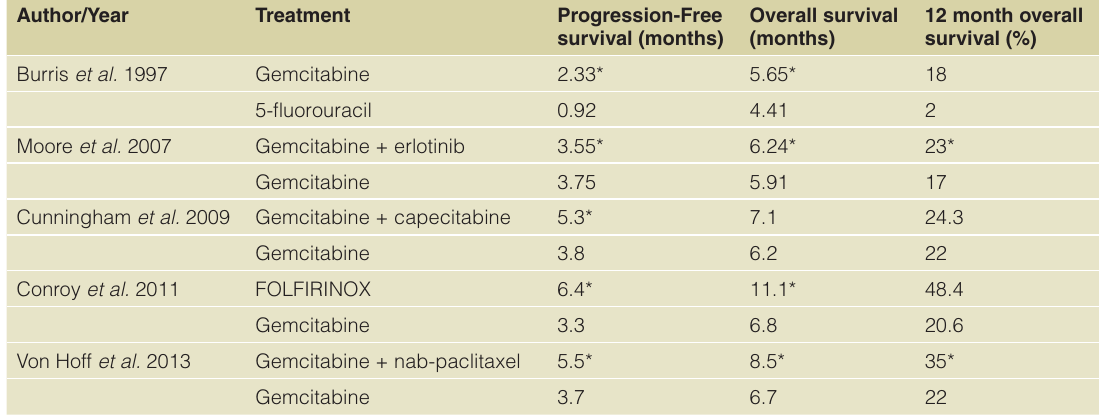
Table 1. Key randomized phase III trials of first-line chemotherapy for metastatic pancreatic cancer.